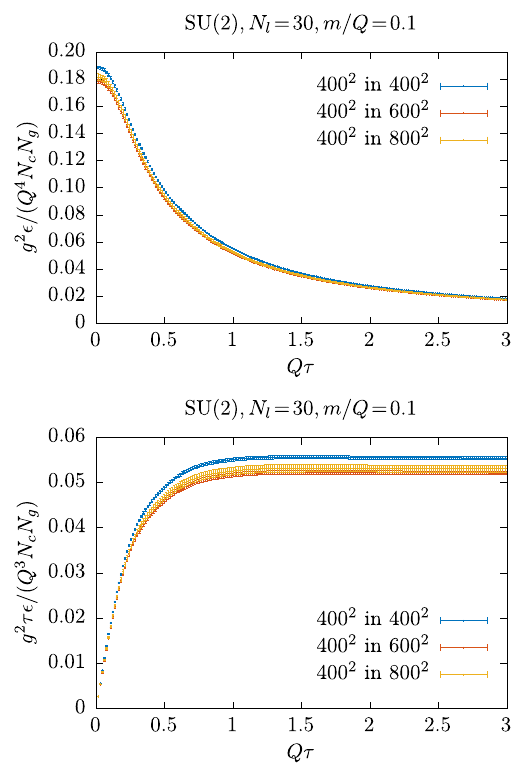
Fig. 2 Total energy density (top) and total energy density times the proper time (bottom) for a nucleus represented by 400 2 lattice points embedded in different lattice